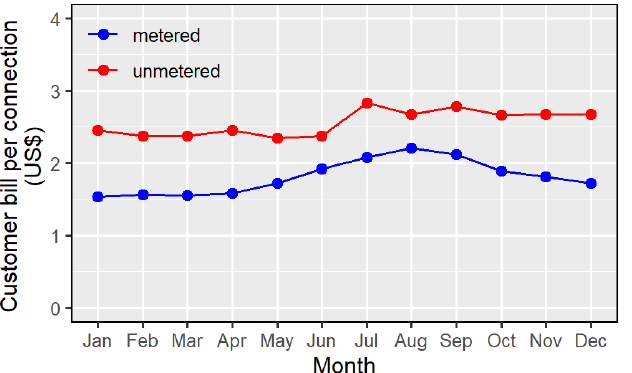
Figure 10. Monthly average bill per connection for metered and unmetered consumers in Tajpura in 2020.